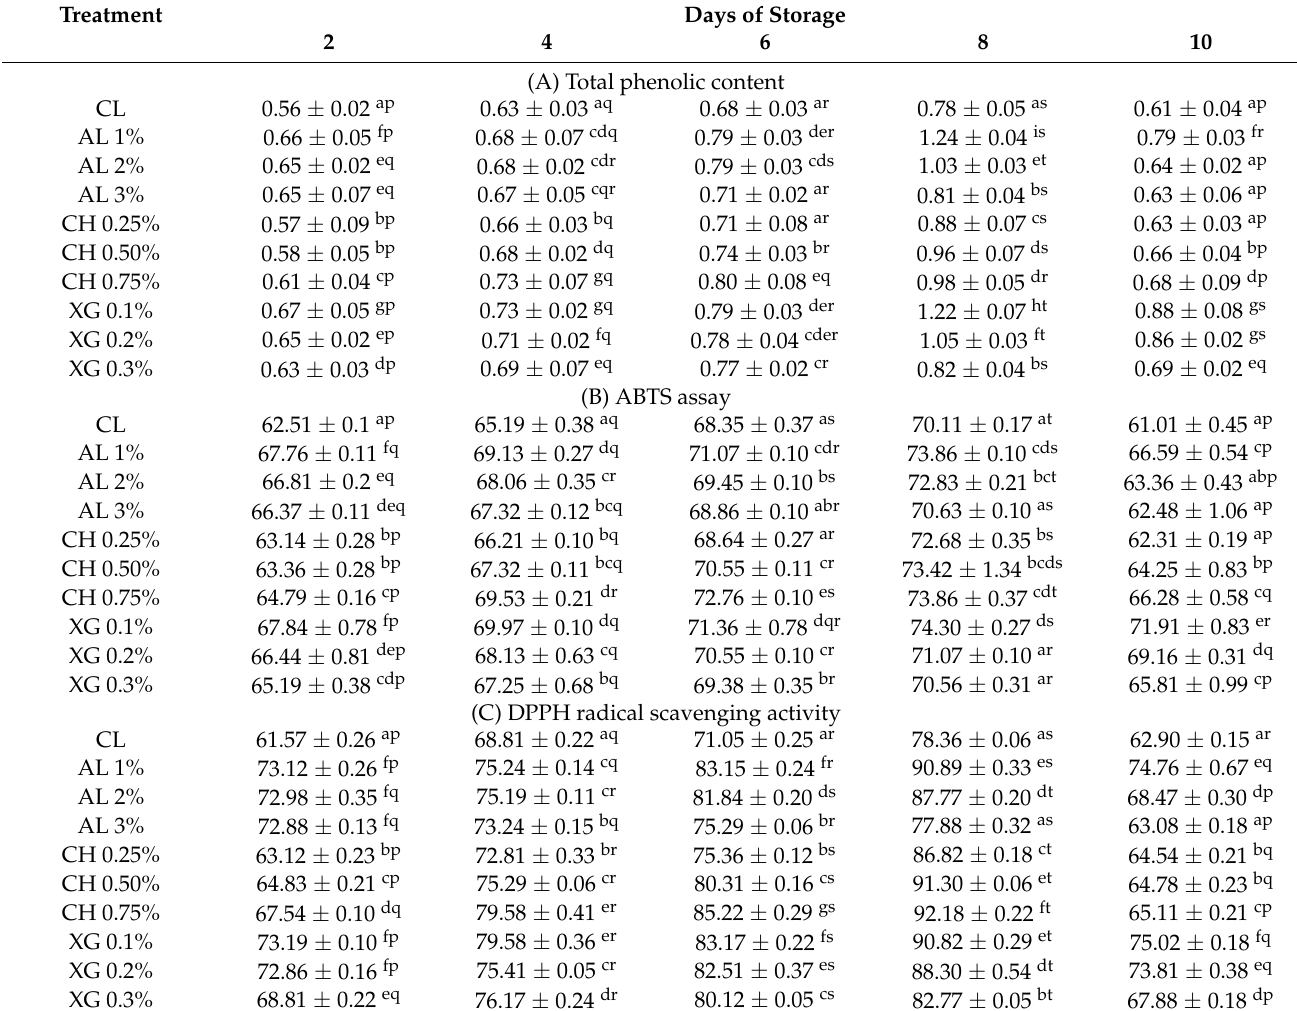
Table 2. Effects of polysaccharide-based coatings and storage on total phenolic content (mg GAE/g DW), ABTS assay (% inhibition), DPPH radical scavenging activity (% inhibition) and lipid peroxidation assay (% inhibition) values.